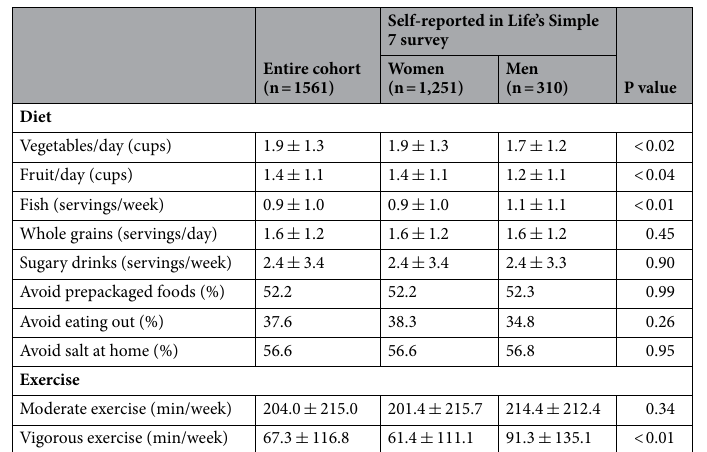
Table 2. Participant self-reported diet and weekly exercise data. Categorical variables are analyzed by Chi- Square test. Continuous variables are analyzed by